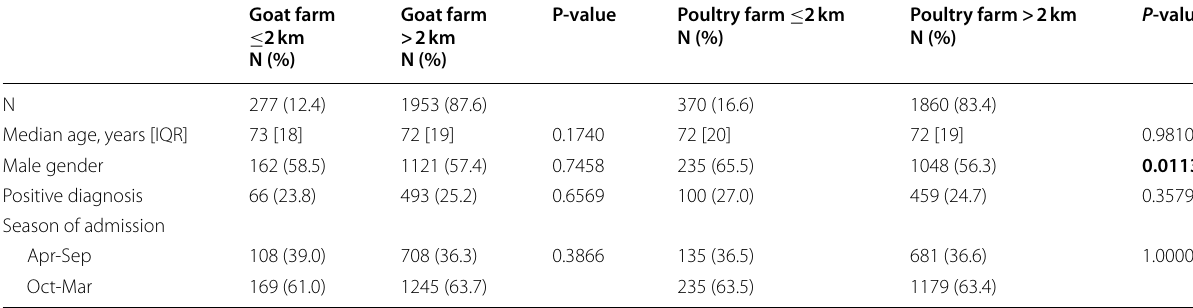
Table 1 Characteristics of hospitalized pneumonia patients, grouped by livestock farm exposure